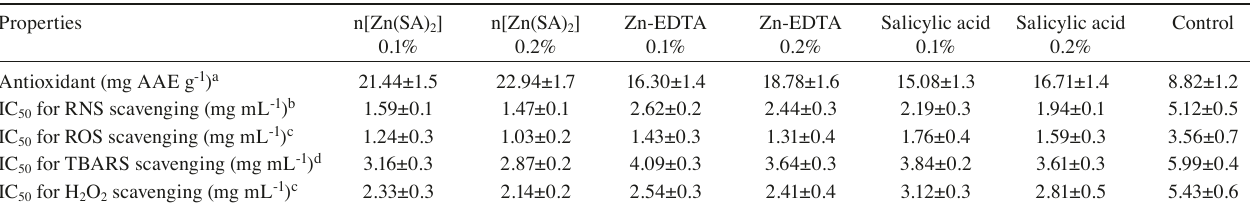
Tab. 3: Radical scavenging activity of sweet basil’s essential oils affected by different zinc and salicylic acid sources. Properties